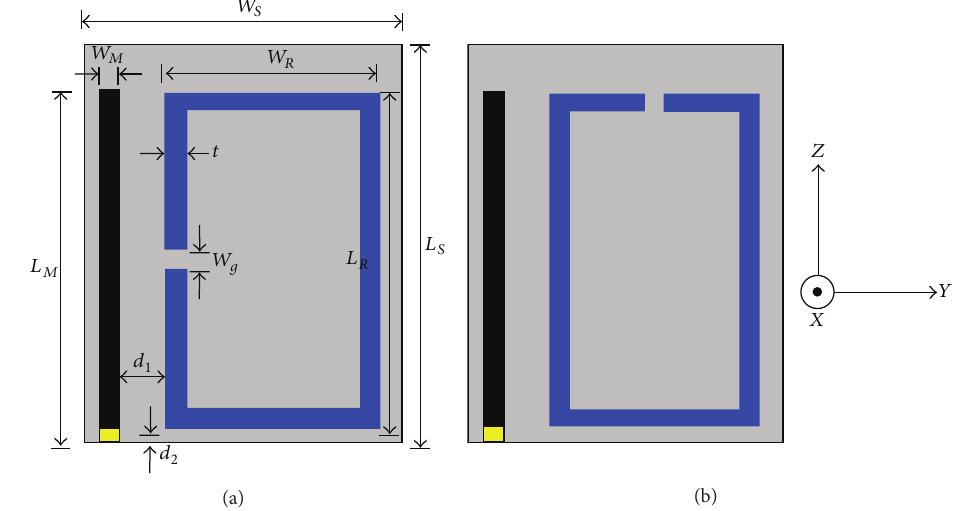
Figure 2: Geometry of the antenna: (a) configuration A1, (b) configuration A2.